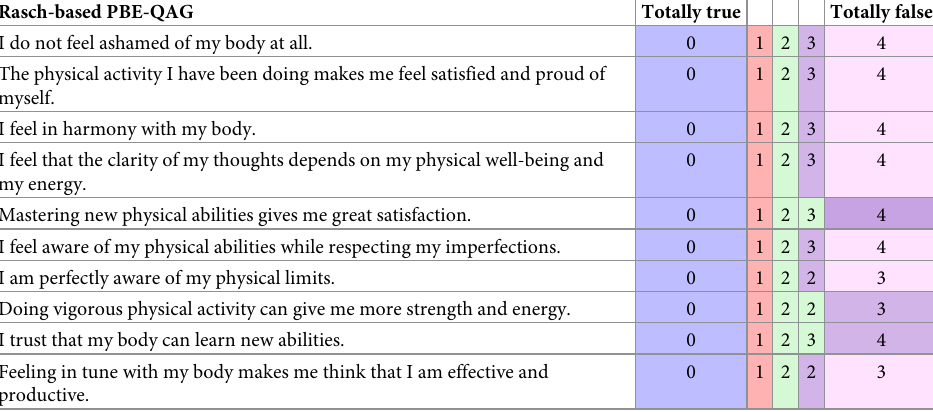
Table 3. Revised Rasch-based PBE-QAG for all community-dwelling adults (without adults with stroke). Rasch-based